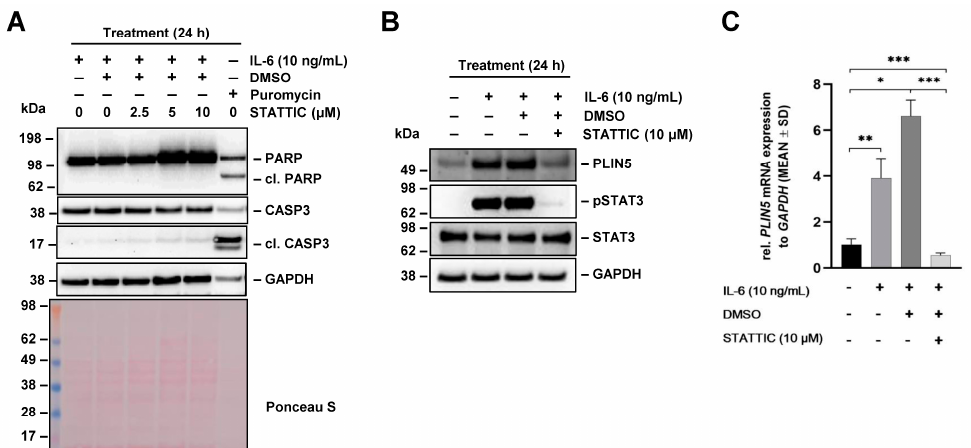
Figure 6. Effects of STATTIC on IL-6-mediated PLIN5 upregulation in Hep3B. ( A ) Hep3B cells were pretreated with STAT3 phosphorylation inhibitor STATTIC (10 µM) for 1 h and then treated for 24 h with IL-6 (10 ng/mL) and the expression of poly (ADP-ribose) polymerase (PARP), cleaved PARP, caspase-3 (CASP3), and cleaved CASP3 was analyzed by Western blot. ( B ) PLIN5 expression and STAT3 phosphorylation was analyzed by Western blot analysis demonstrating that STATTIC blocked IL-6-induced PLIN5 protein expression. The quantities of GAPDH and Ponceau S staining served as controls to demonstrate equal protein loading. ( C ) Effect of STATTIC on PLIN5 mRNA expression was tested by RT-qPCR. Significant differences between the groups are marked by asterisks (* p < 0.05, ** p < 0.01, *** p < 0.001).